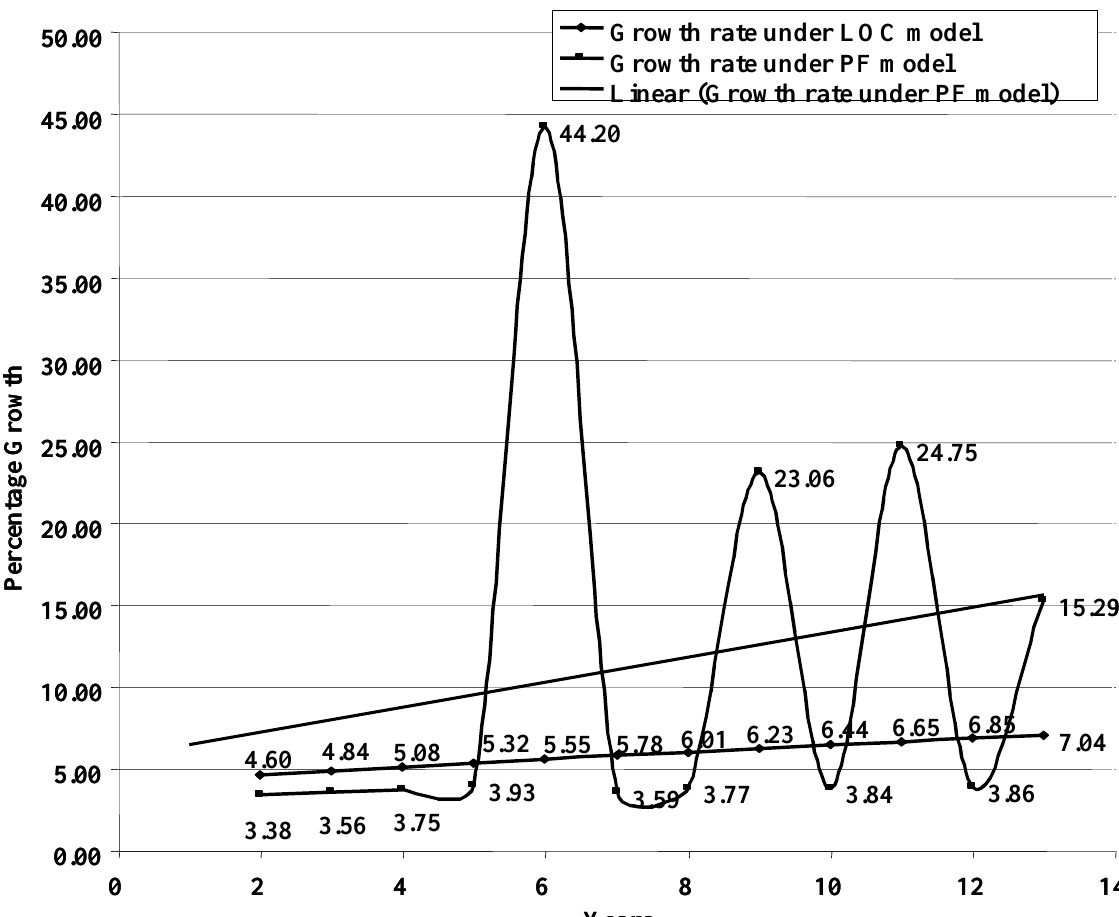
Figure 3 : Comparison of the Growth Rates of the PF and the LOC